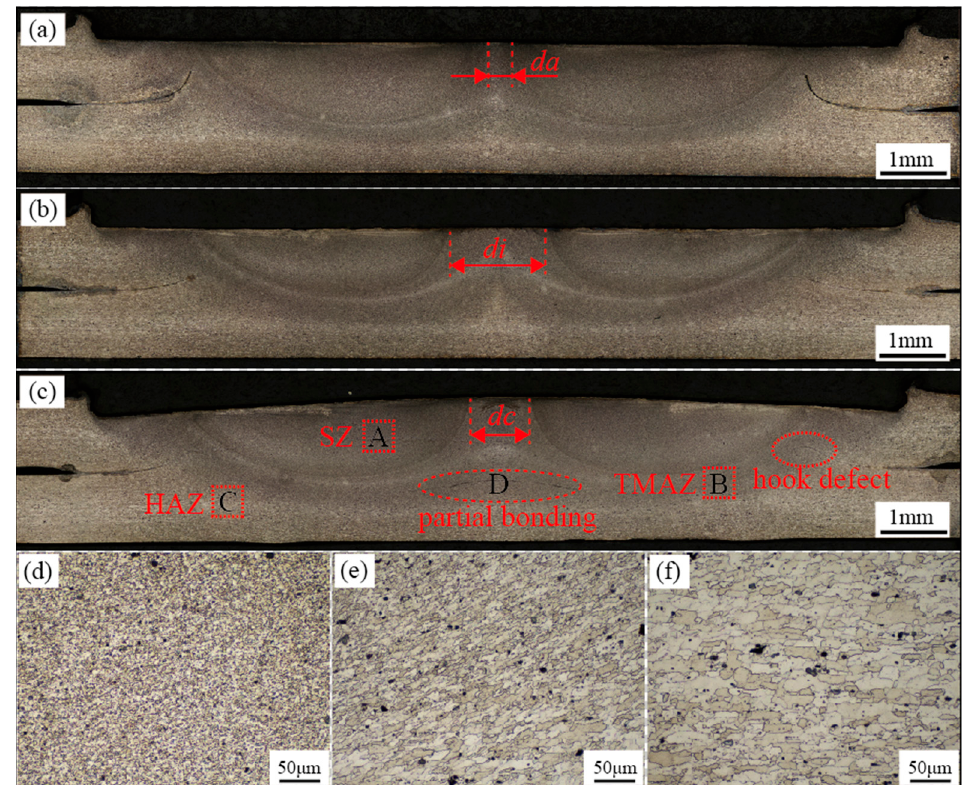
Figure 7. Microstructures of 7075-T651 aluminum alloy joints P-FSSWed with the ( a ) archimedes tool, ( b ) involute tool, ( c ) concave tool in regions ( d ) A, ( e ) B, and ( f ) C in Figure 7c, respectively.